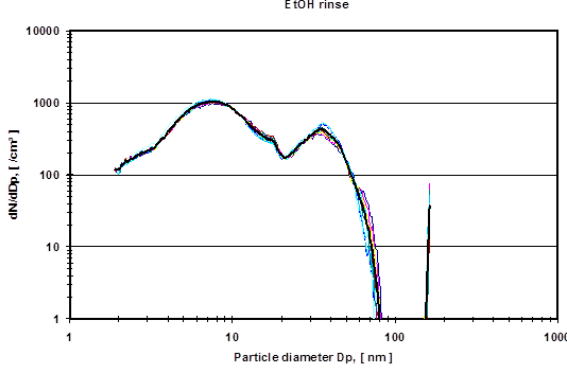
Figure 6. Ethanol probe, metal-on-metal, dilution 1:5, 1:25, 1:100 and pure.